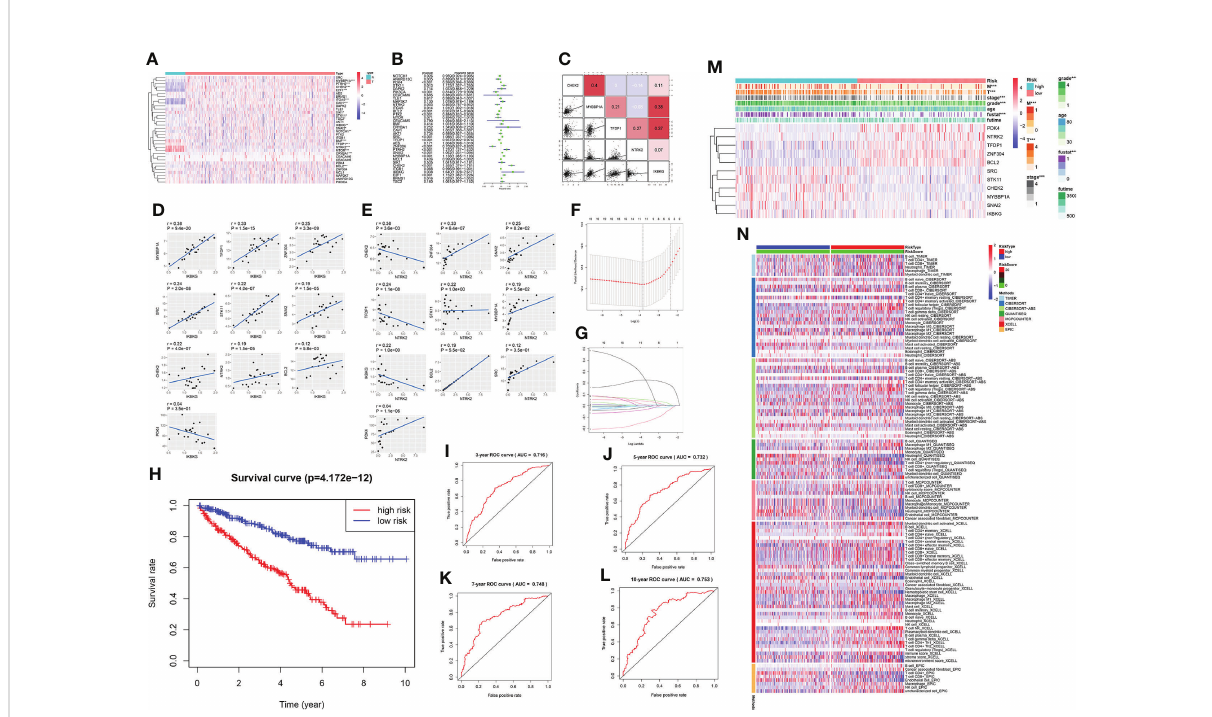
FIGURE 6 A prediction modelof KIRC using anoikis-relatedgenes. (A) Expression ofanoikis-related genes in patients withKIRC.Red and blue colorsrepresent upregulation and downregulation, respectively. N (green) represents the normal sample; T (red)represents the tumor sample(*p < 0:05, **p < 0:01, and ***p< 0:001). (B) Hazardratio analysiswith 95% con fi dence intervals and p values for the anoikis-related genes. (C) Co-expression relationship between 5 anoikis-related genes with signi fi cant statistical signi fi cance. Their regression relationshipis displayed with scatterplots. The correlation coef fi cient is represented by a color:a positive correlation is red; a negative correlationis blue;the deeperthe color, the greaterthe correlation. (D) The scatterdiagramshows the correlationof IKBKGand other genes, including MYBBP1A, TFDP1, ZNF304,SRC,STK11, SNAI2,CHEK2, BCL2,PDK4, and NTRK2. (E) The scatter diagram shows the correlationof NTRK2and other genes, including CHEK2, ZNF304,SNAI2,TFDP1, STK11, MYBBP1A, IKBKG, BCL2, IKBKG, SRC, and PDK4. (F, G) The LASSO coef fi cient pro fi les of anoikis-related genes in KIRC. Eleven genes wereselected using the LASSO Cox regressionanalysis. (H) The survival curve obtained using this model. Redand blue colorscorrespond to the high- and the low-risk groups, respectively. (I – L) ROC curve represents data of3,5,7, and 10years. AUC is marked at the head (3years: 0.716; 5 years: 0.732; 7 years: 0.748; and 10 years: 0.753). (M) Heatmap shows the correlationof the eleven selected genes and theirclinicopathological characteristics in the two groups. The color barrepresentsthe expression of genes; red and blue represent upregulation and downregulation, respectively. (N) Heatmap for immune responses based ondifferent algorithmsamong the highand low-risk groups. Different algorithmsarerepresented by different colored area